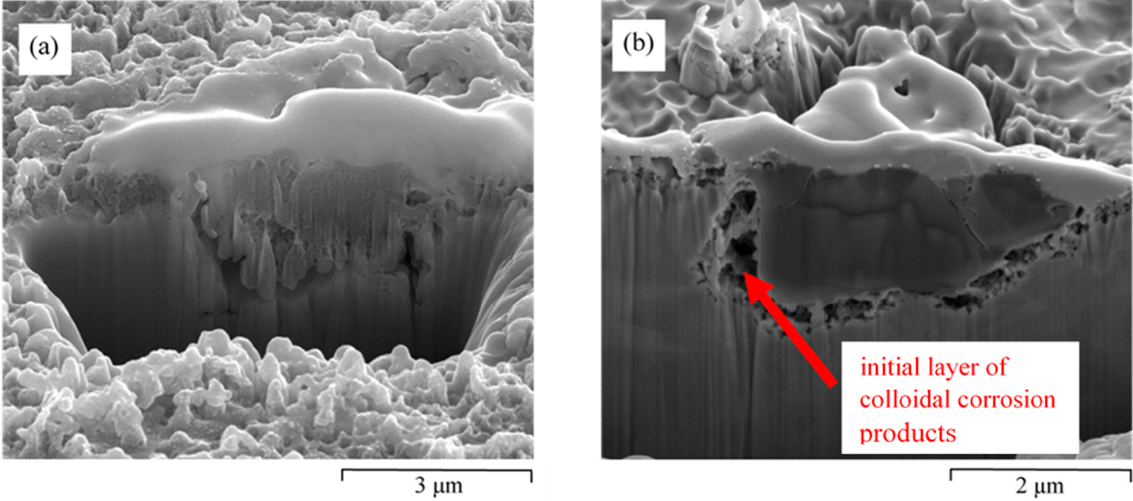
Figure 4. ( a , b ) FIB-SEM cross-sections of the biofilm formed on carbon steel and corrosion pitting due to pure culture of IRB in Postgate C medium following a 72 h exposure.